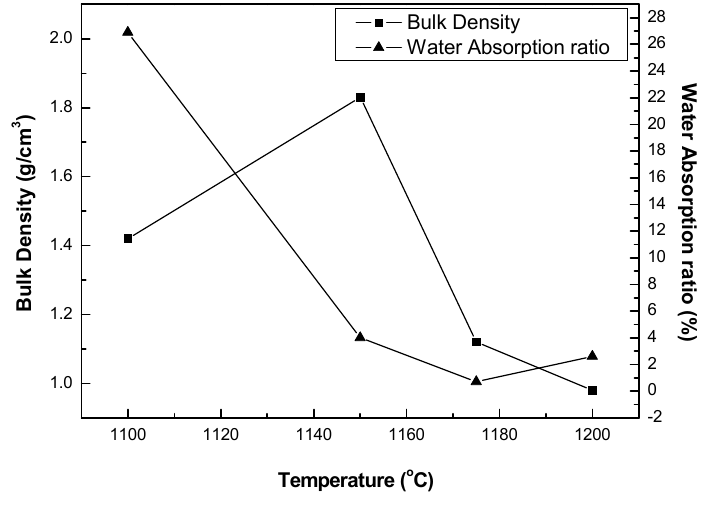
Figure 5. Bulk density and water absorption ratio of the sample fired by the rapid sintering method.